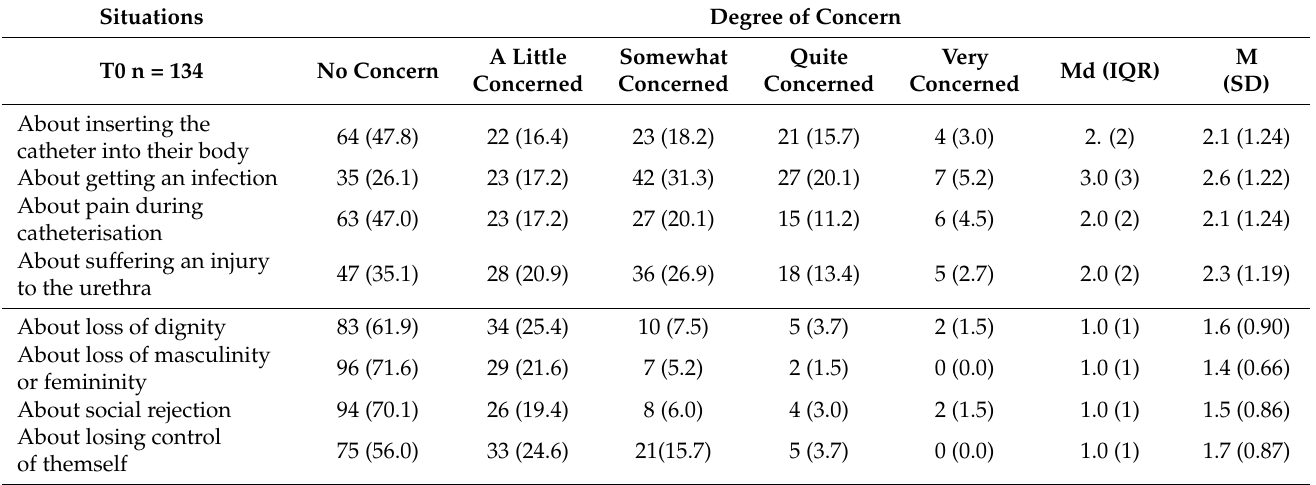
Table 4. Patients’ degree of concern over different problems that could be attributed to the catheteri- sation at the first visit.